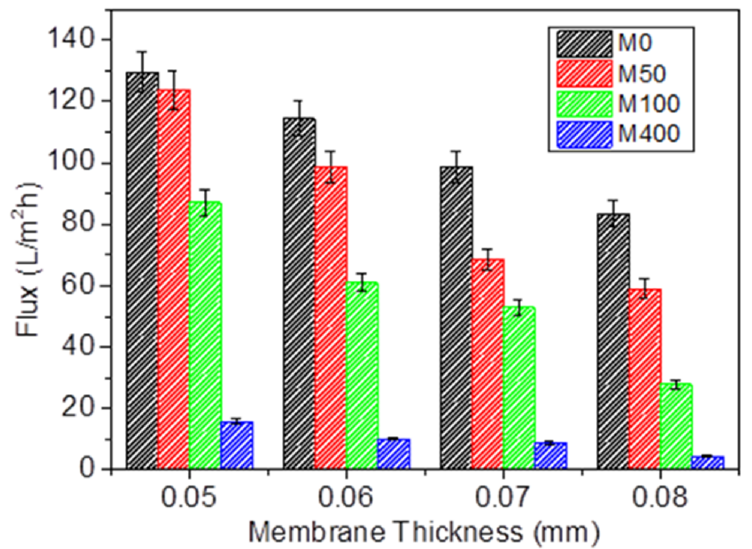
Figure 5. The permeability of nanocomposite membranes with different thicknesses based on the dead-end system at a 2 bar pressure.